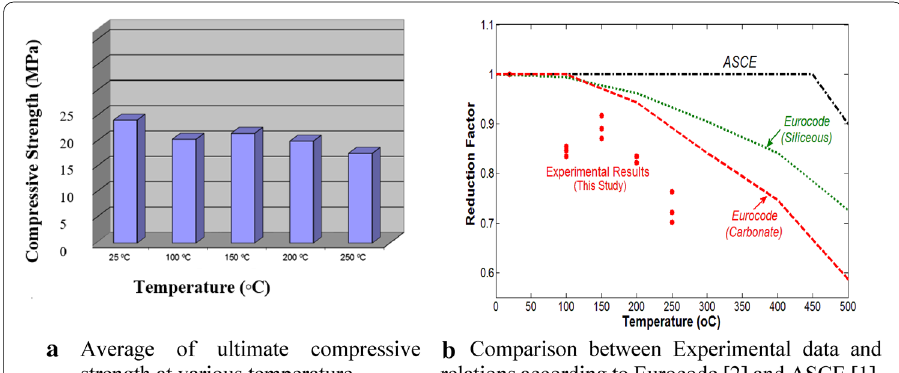
Fig. 2 Deviation of concrete compressive strength at elevated temperature